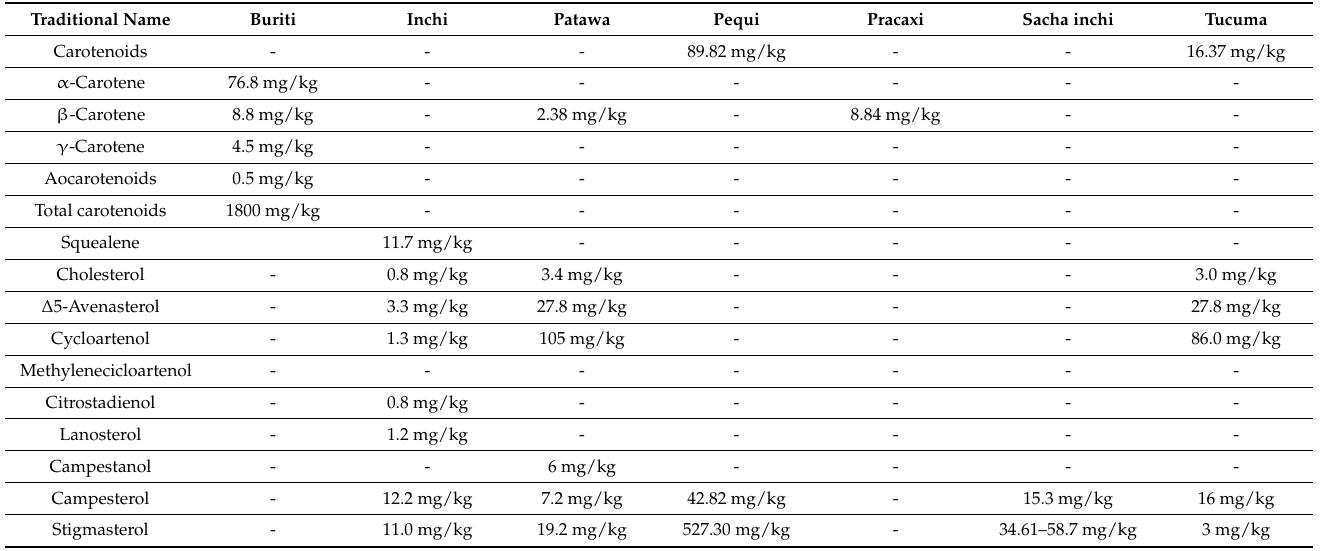
Table 3. Minority compounds of different Amazonian vegetable oils by alphabetical order; (-) not